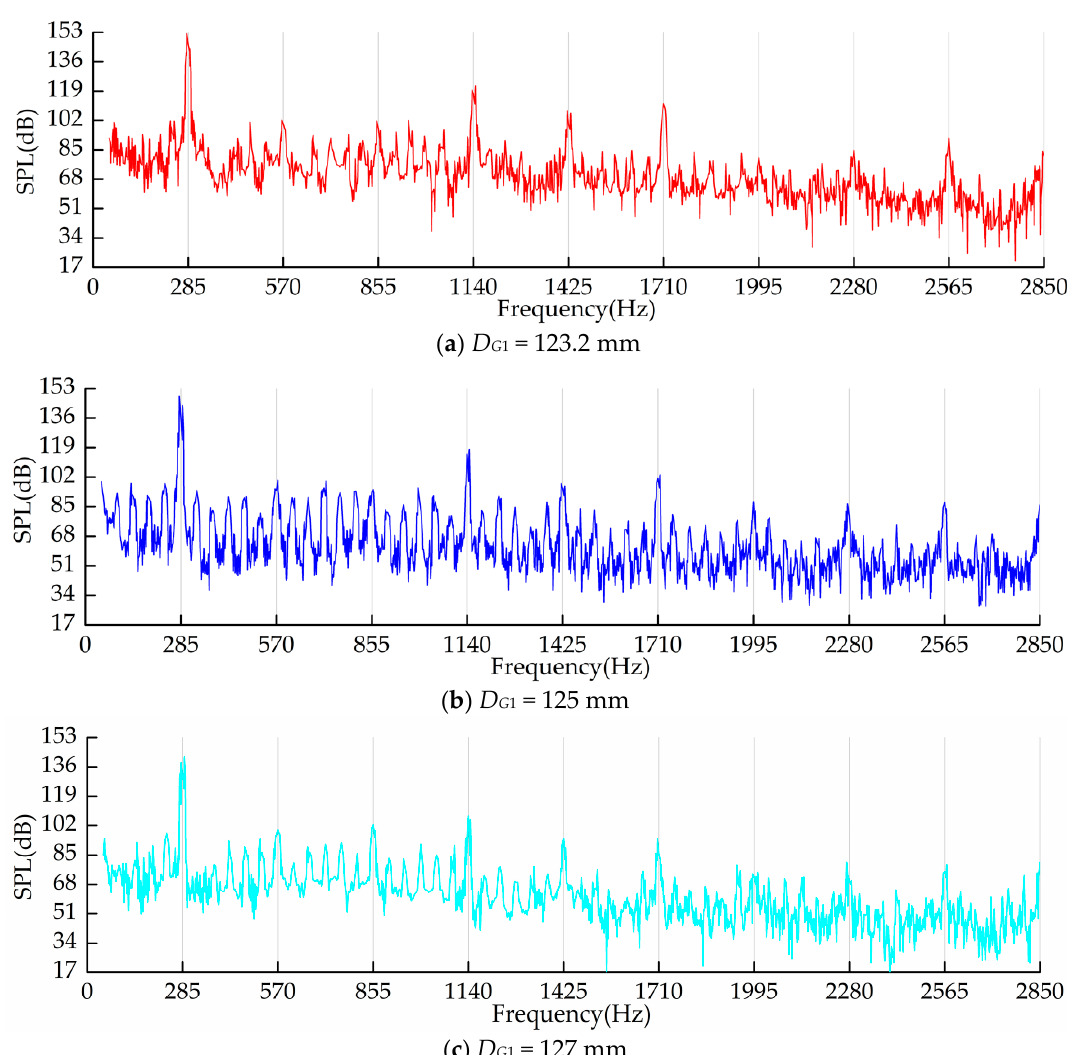
Figure 24. Frequency response curves of the hydroacoustic SPL inside the impeller with different inlet diameters of the positive guide vane.